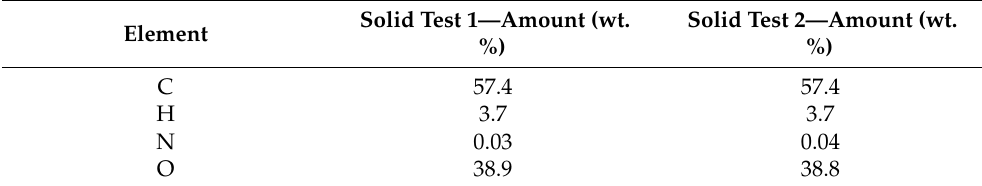
Table 3. Elemental analysis of the solid residues obtained from HTL test 1 (345 ◦ C, 30 min) and test 2 (345 ◦ C, 20 min). Element Solid Test 1—Amount (wt. %)